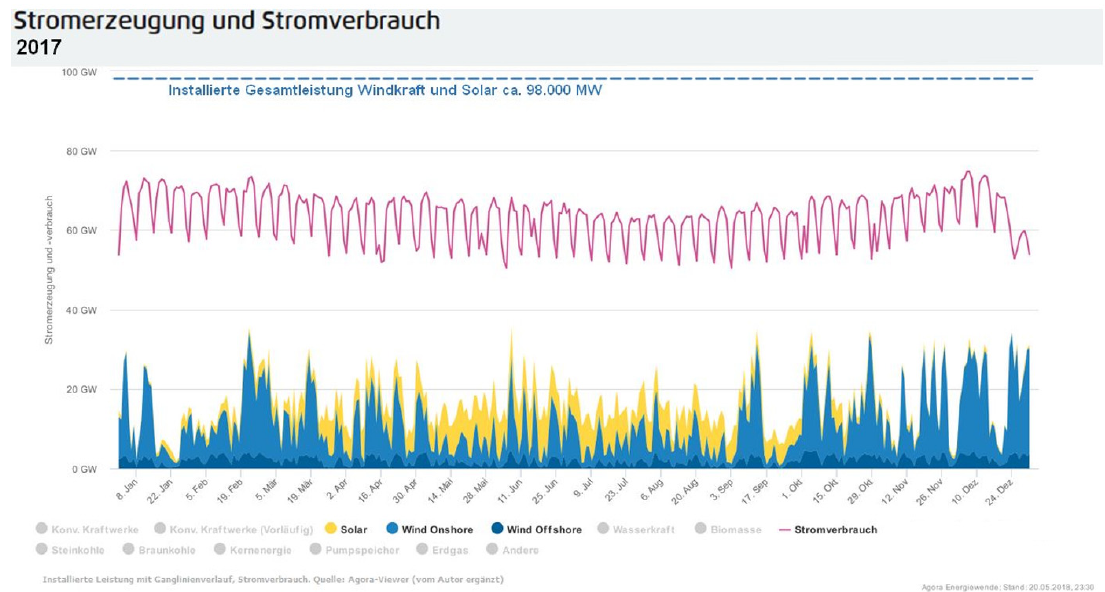
Figure 8. Data show the consumption of total electricity in Germany, along with electricity produced from renewable energy sources (such as wind, either offshore or onshore, and solar) in calendar year 2017 [32,33].